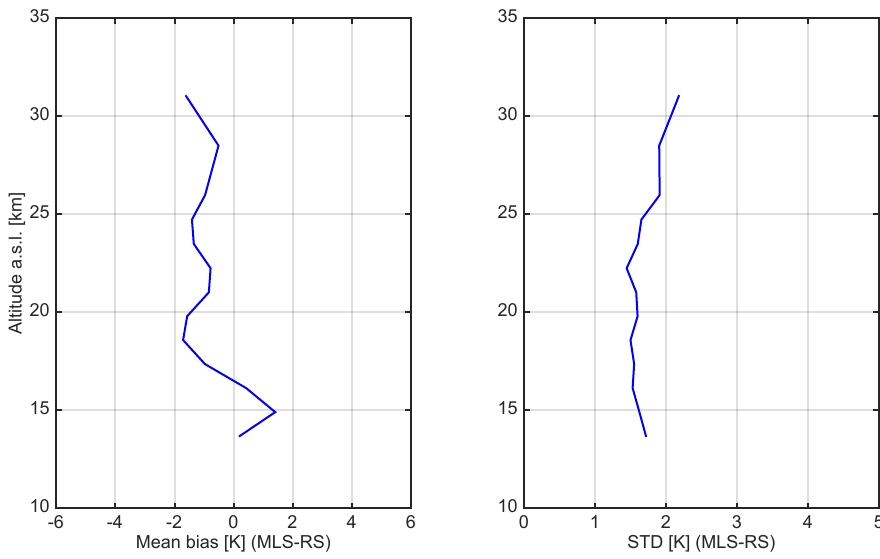
Figure 11. Mean bias and standard temperature deviation between MLS and